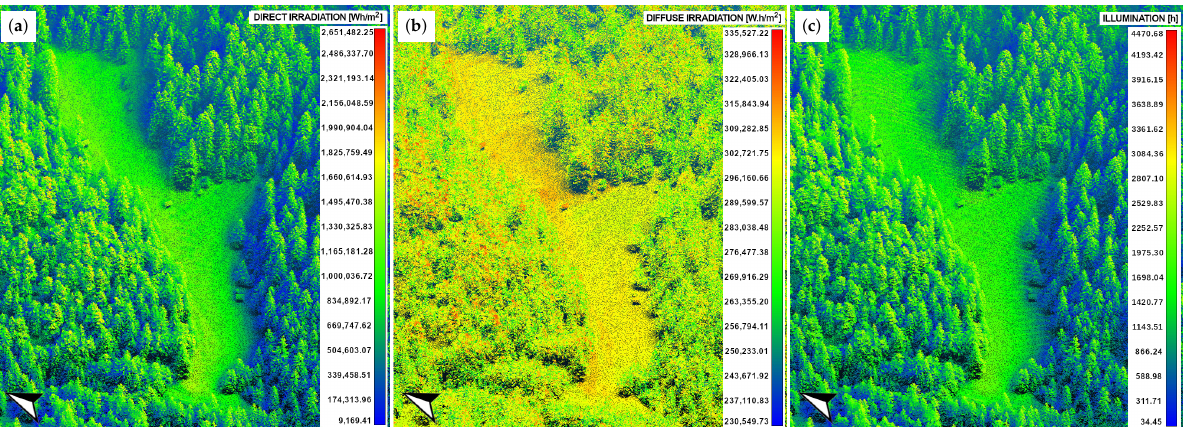
Figure 4. The annual sums of the ( a ) direct solar irradiation, ( b ) diffuse solar irradiation, and ( c ) illumination hours in the Suchá valley, Slovakia (detail). Data source: ÚGKK SR [43].